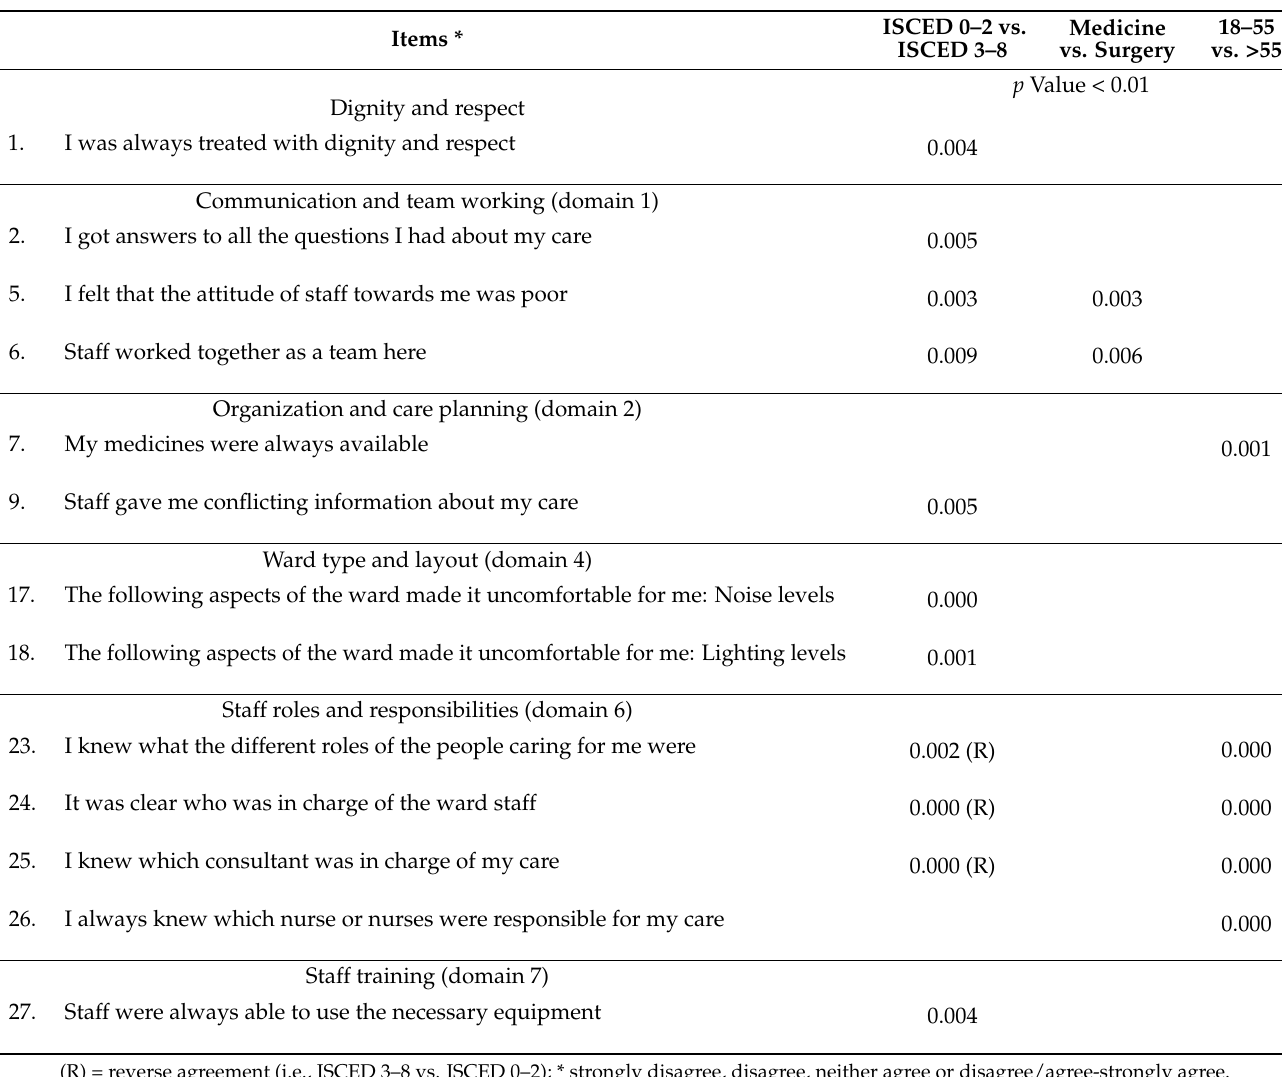
Table 3. Hospital and socio-demographic characteristics with higher agreement.